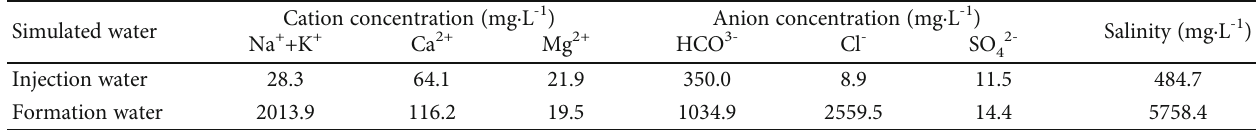
Table 1: The ionic compositions of the injection water and formation water. Simulated